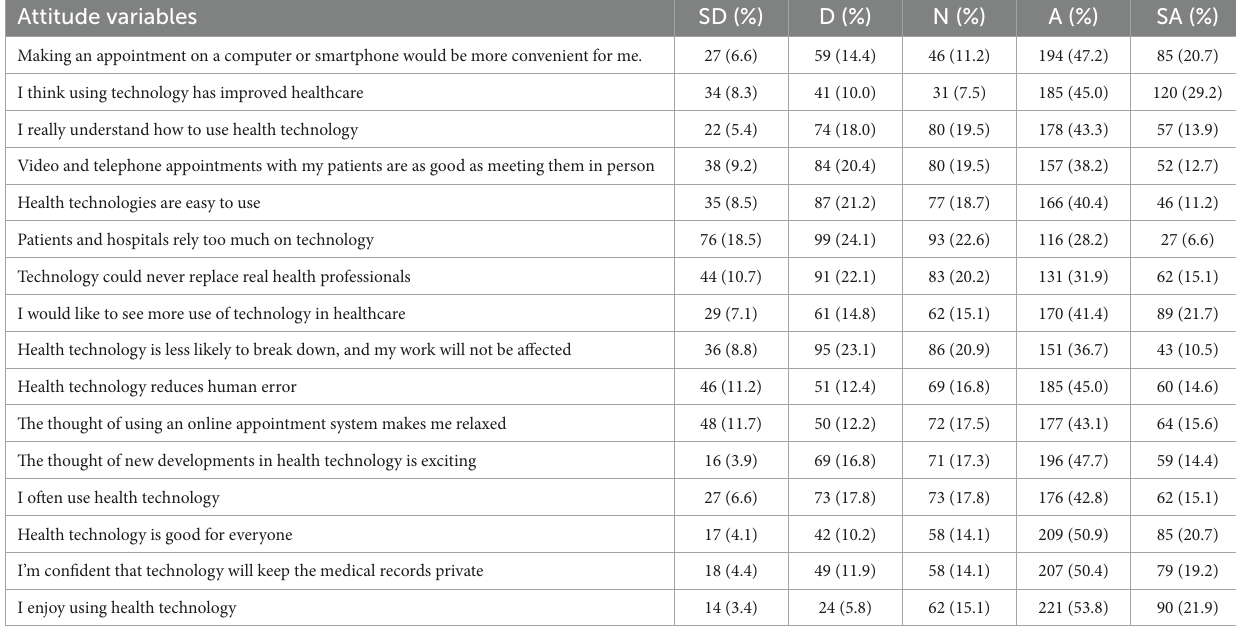
TABLE 3 Attitude towards digital health